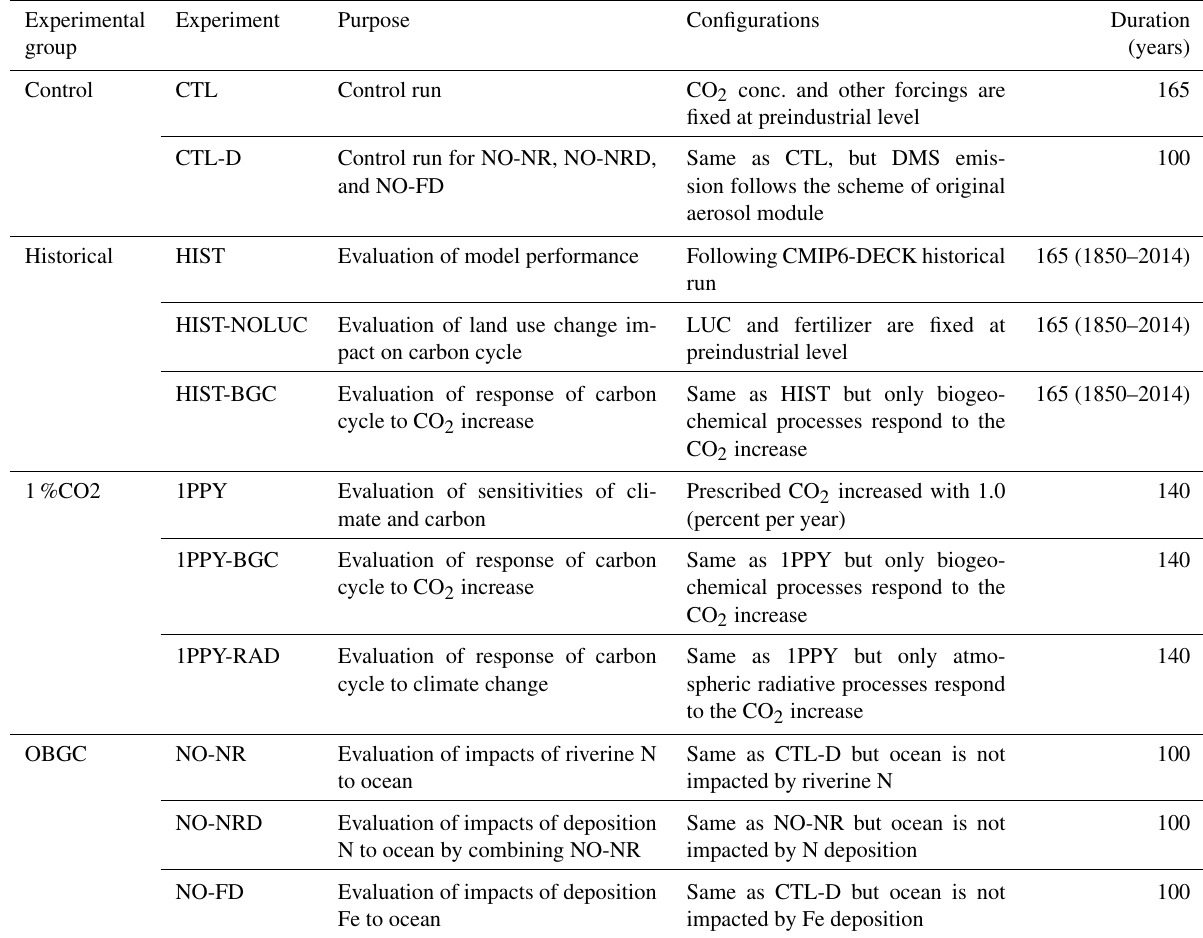
Table 1. Summary of experimental details.